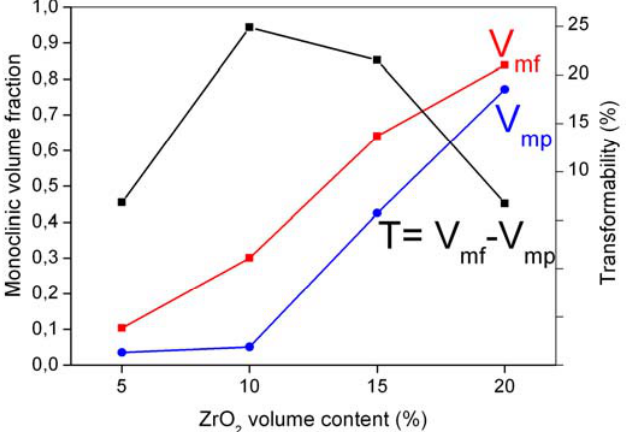
) and fracture (V ) surfaces and mp mf volume fraction in the 2